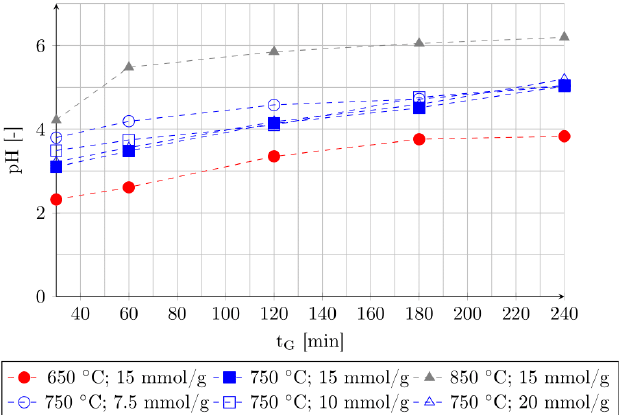
Figure 6. Effect of roasting time, roasting temperature and acid addition on pH value of leach solution ( ϱ PD,L = 25 kg/m 3 ; T L = 20 °C; t L = 24 h; r R,L = 300 rpm).